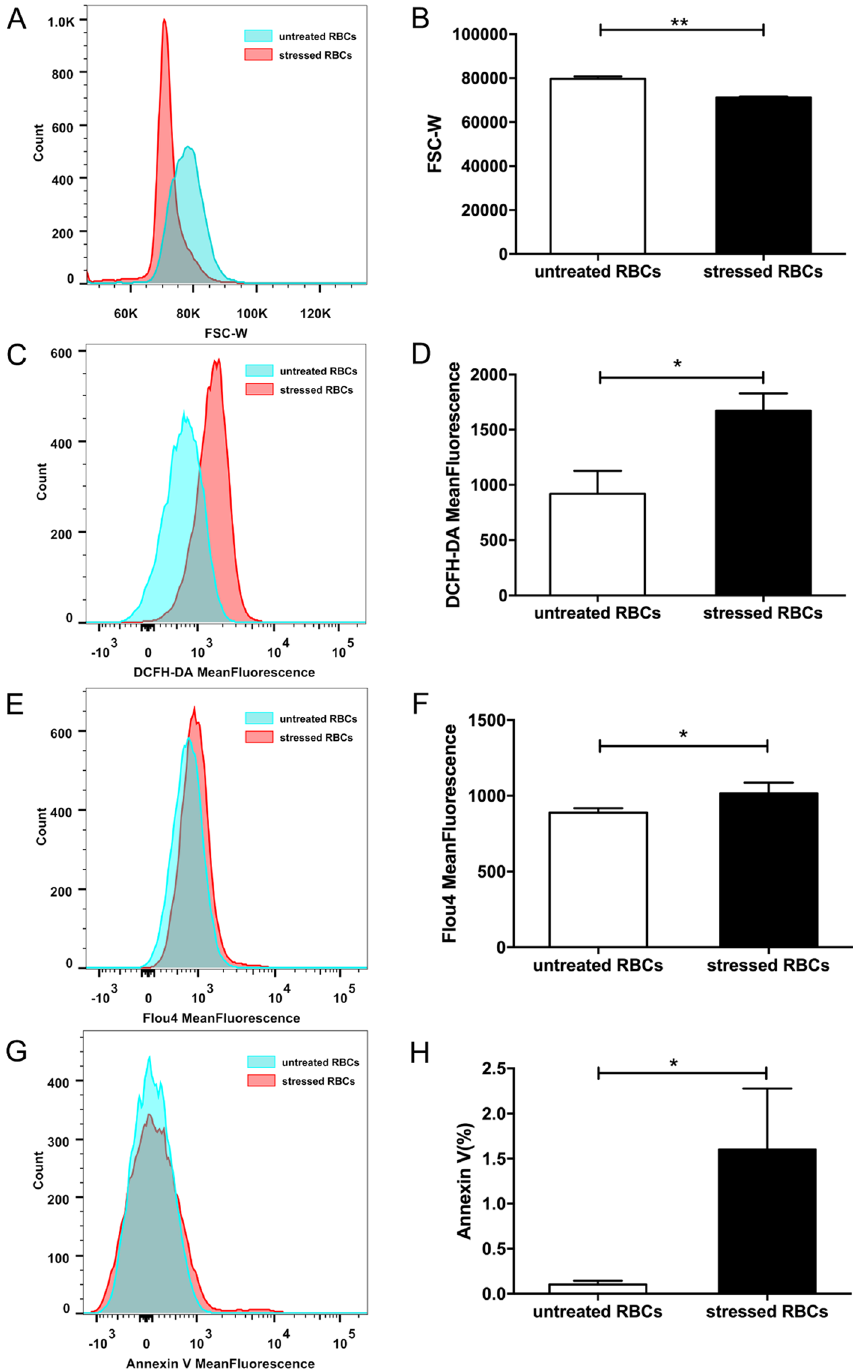
Figure 1. Characteristics of stressed RBCs. RBCs obtained from 8-week-old BALB/c mice were incubated at 48 °C for 30 min or kept at room temperature for 30 min (n = 9). ( A , B ) Cell volume of stressed RBCs and untreated RBCs. Cell volume was represented by forward scatter width. ( C , D ) ROS level of stressed RBCs and untreated RBCs. ( E , F ) Intracellular Ca 2+ concentration of stressed RBCs and untreated RBCs. ( G , H ) PS externalization of stressed RBCs and untreated RBCs (* p < 0.05; ** p <